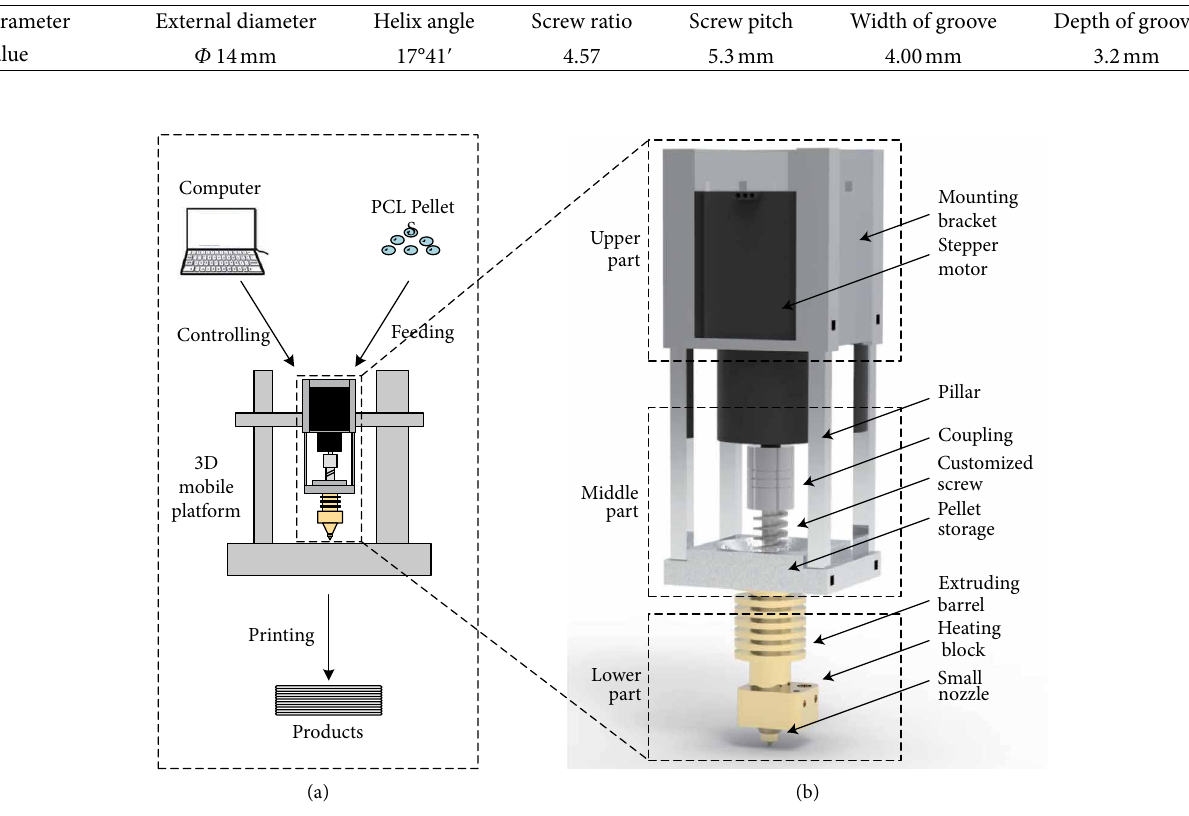
Figure 1: (a) The flow chart of the working system; (b) the details of the printer with three main